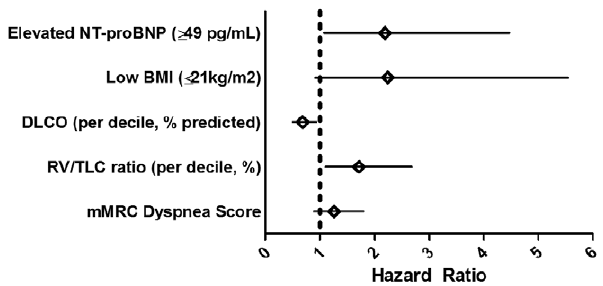
Figure 2. Multivariable Survival Analysis. Forrest plot showing survival hazard ratios. All variables were analyzed independently in a proportional hazard model incorporating group (patient cohort), age, gender, and degree of airflow obstruction (FEV1 percent predicted). Shown are estimated hazard ratio (diamonds) and 95% confidence intervals (whiskers). Due to missing values, the number of individuals differs slightly in each model, as follows: NT-proBNP (n=779), Low BMI (n=664), DLCO percent predicted (n=665), RV/TLC ratio percent predicted (n=569), mMRC dyspnea score (n=761). Definitions of abbreviations: BMI=body mass index; DLCO=diffusion capacity